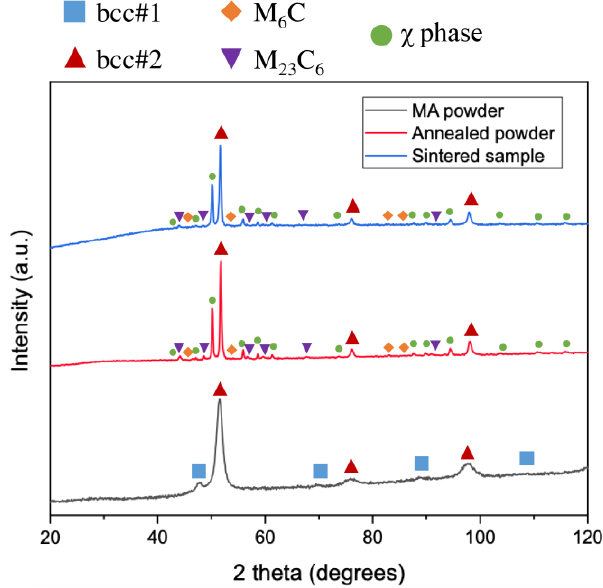
Figure 1. XRD patterns of MA powder, annealed powder, and sintered sample.